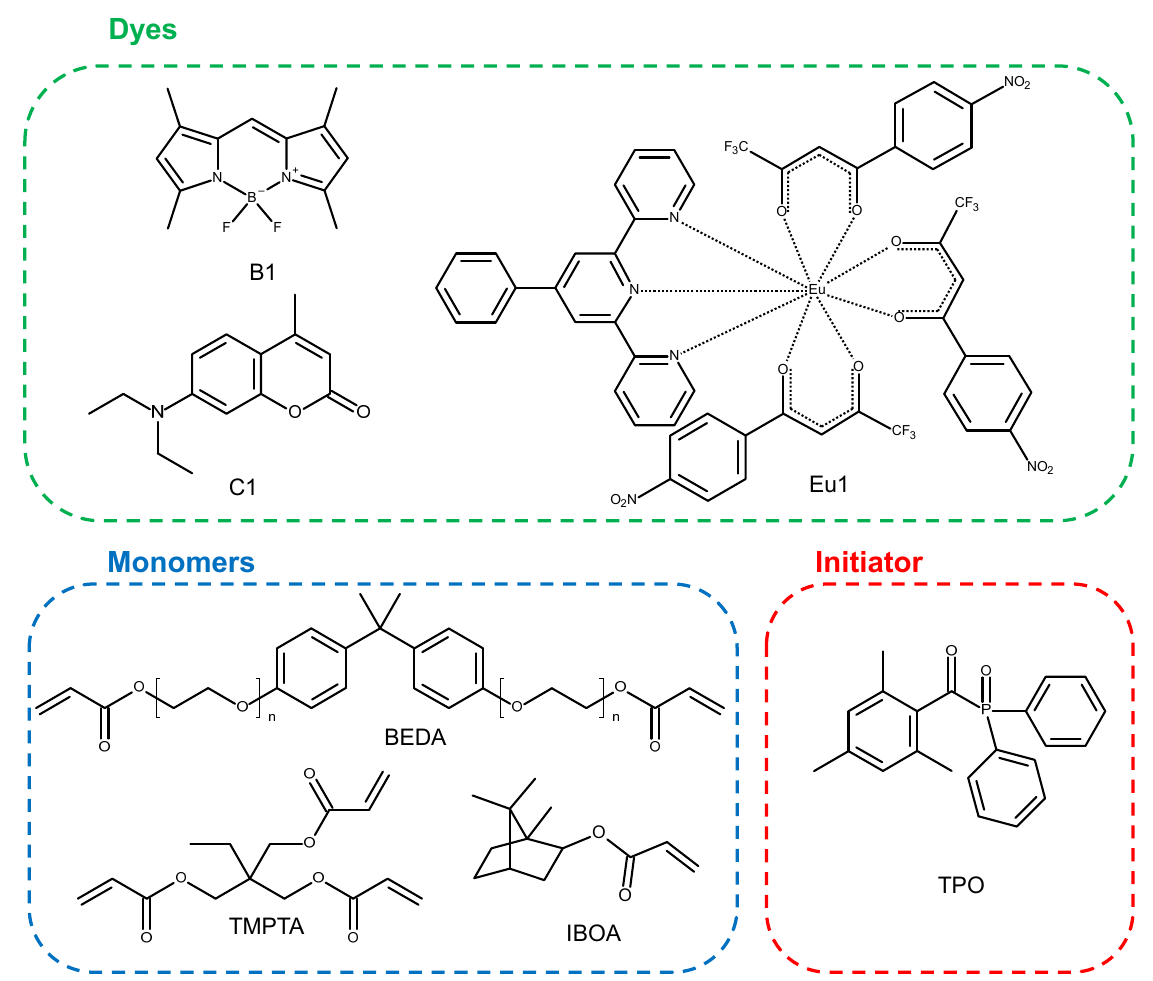
Figure 9. Structures of molecular fluorescent dyes, monomers, and initiator used for photopolymerisation processes.